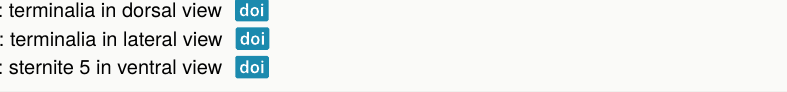
Vibrissina randycurtisi sp. n. can be di ff erentiated from its congeners by the combination of the following traits: parafacial and parafrontal all gold; ground color of T5 black in both sexes; abdominal tomentum covering over 30% of ST1+2, T3, and T4; females bearing only 1 pair of marginal bristles on segments ST1+2 and T3, and a single row of marginal bristles on